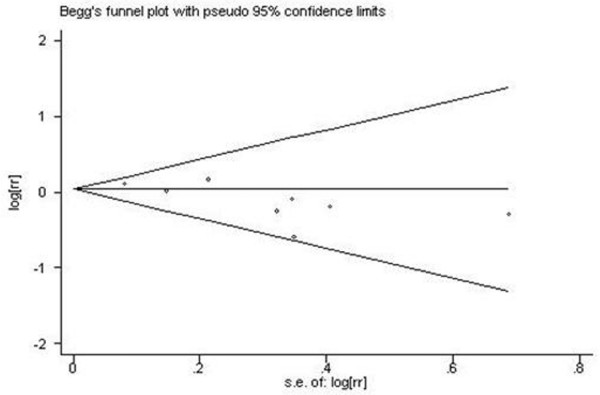
Begg's funnel plot for publication bias in meta-analysis of premature birth and breast cancer risk. Premature birth (gestational age ≤36 weeks) was compared with gestational age ≥37 weeks. Egger test, P = 0.03; Begg test, P = 0.11. rr, relative risk; s.e., standard error.